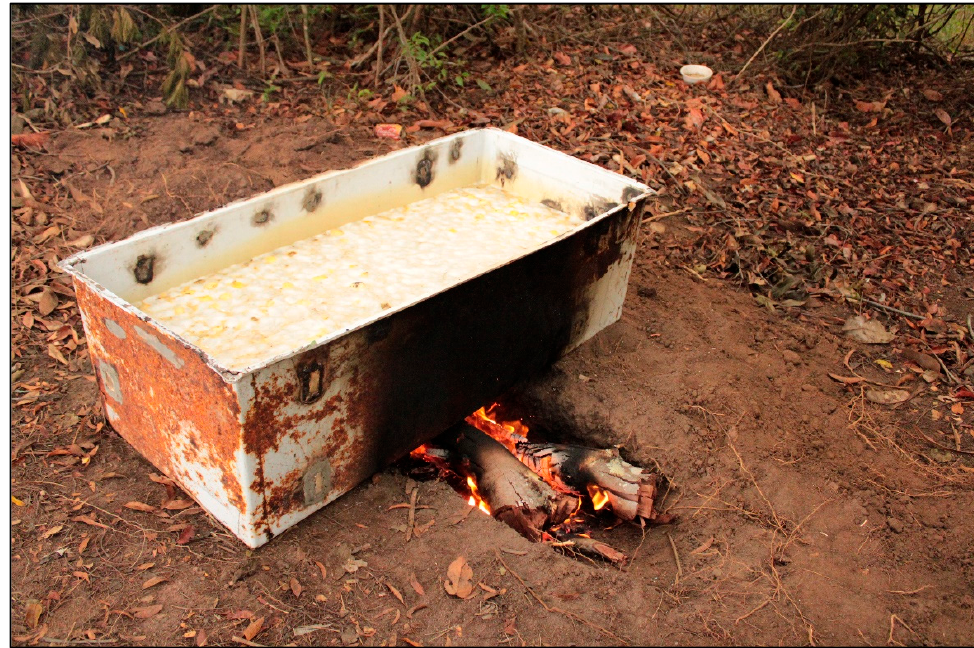
Figure 4. Process of cooking the fruits of Caryocar coriaceum Wittm. in boilers for the production of oil at the Barreiro Novo camp, Jardim—CE, Brazil.